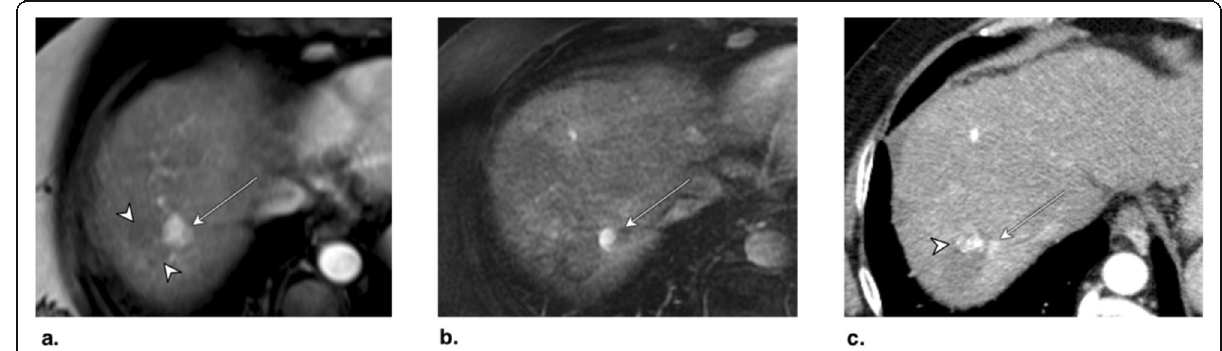
Fig. 30 Axial T1-weighted MR in late arterial phase (AP) obtained ( a ) pretreatment: image shows recurrence (arrow) of a lesion previously treated with radiofrequency and transarterial chemoembolization (TACE) (arrowheads). b 2 months post stereotactic body radiotherapy (SBRT): image shows incomplete tumor regression. c Axial CT in late AP obtained 5 months post SBRT: image shows faint residual enhancement (arrow) that may represent expected enhancement pattern. The treated observation is categorized LR-TR equivocal. Note the ethiodized oil retention from previous TACE